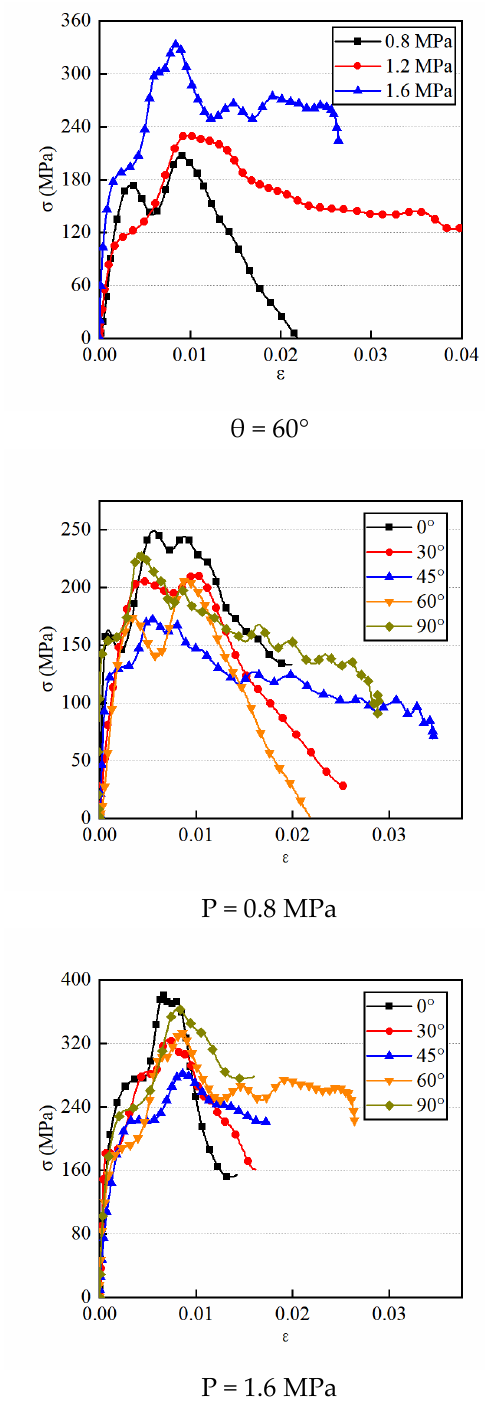
Figure 4. Stress–strain curve of the samples under different loading conditions.